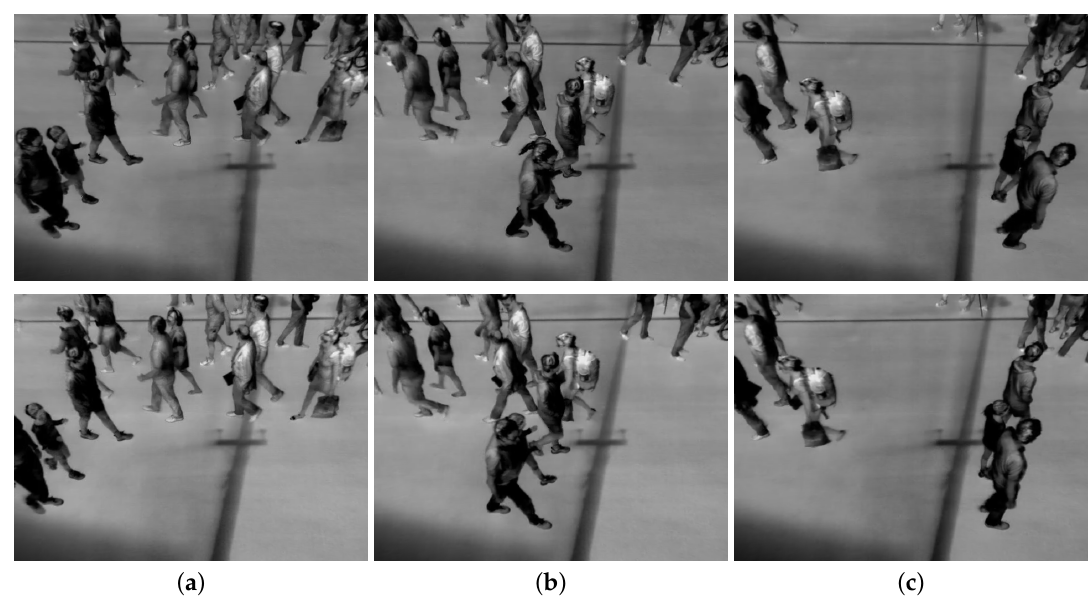
Figure 3. Example of pedestrians occluding each other. The upper row displays left camera images, while the bottom row displays right camera images. ( a ) is frame 0, ( b ) is frame 45, and ( c ) is frame 90. Note the two people entering the lower left side of the images in (a); in (b) the child is almost fully occluded, while she appears again in